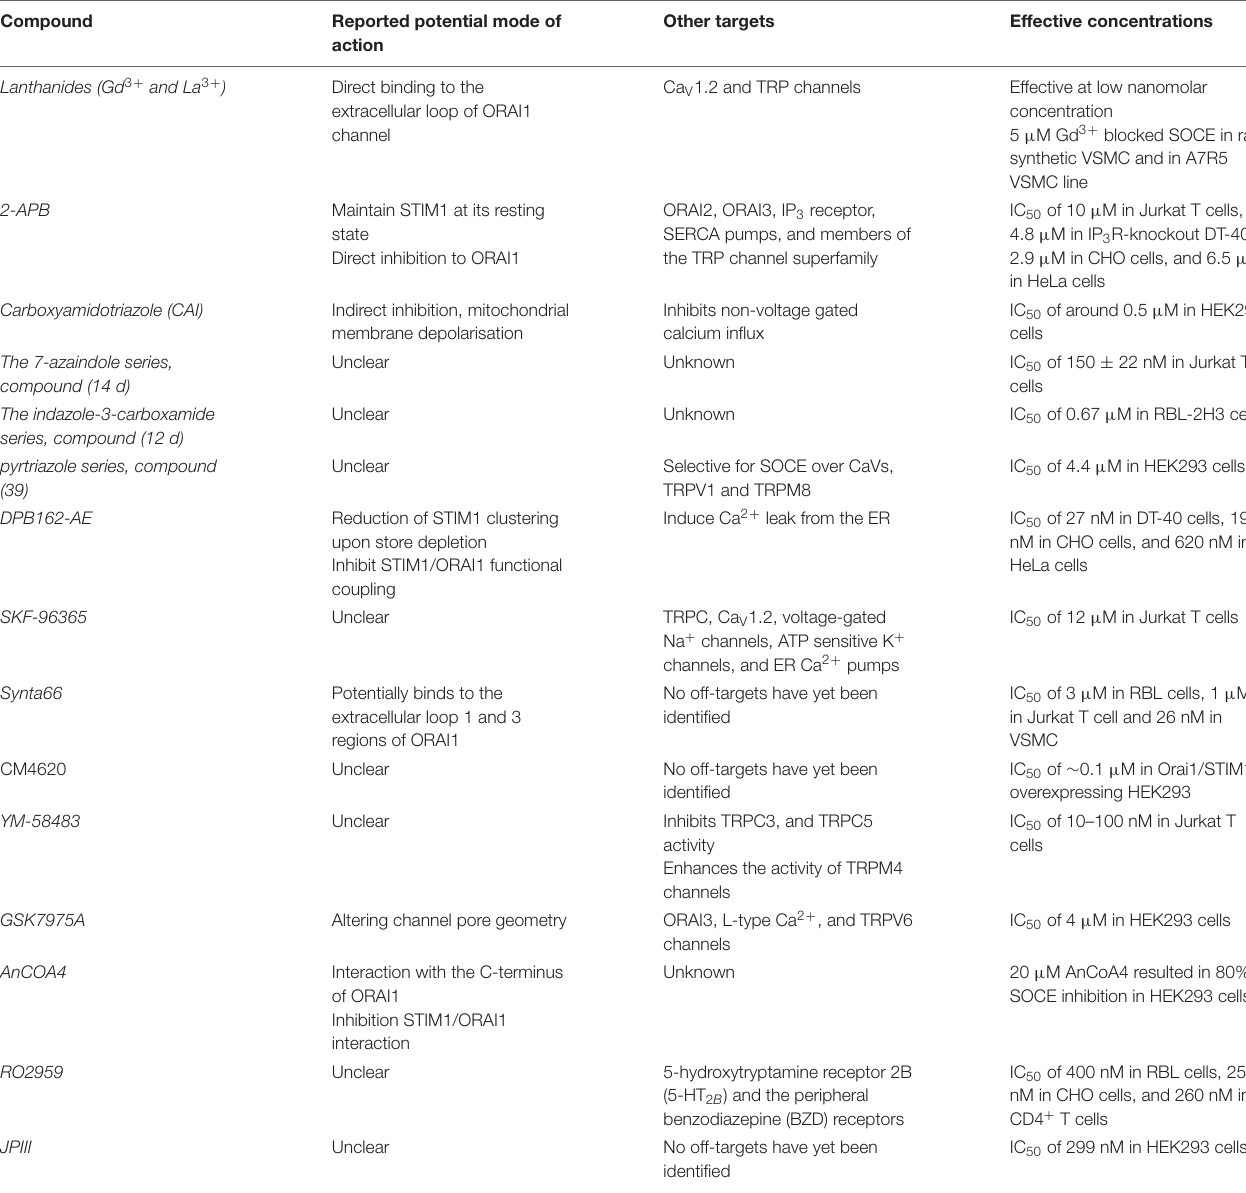
TABLE 3 | Features of ORAI1 channel pharmacological inhibitors. Compound Reported potential mode of Other targets Effective concentrations action Lanthanides (Gd 3 + and La 3 +